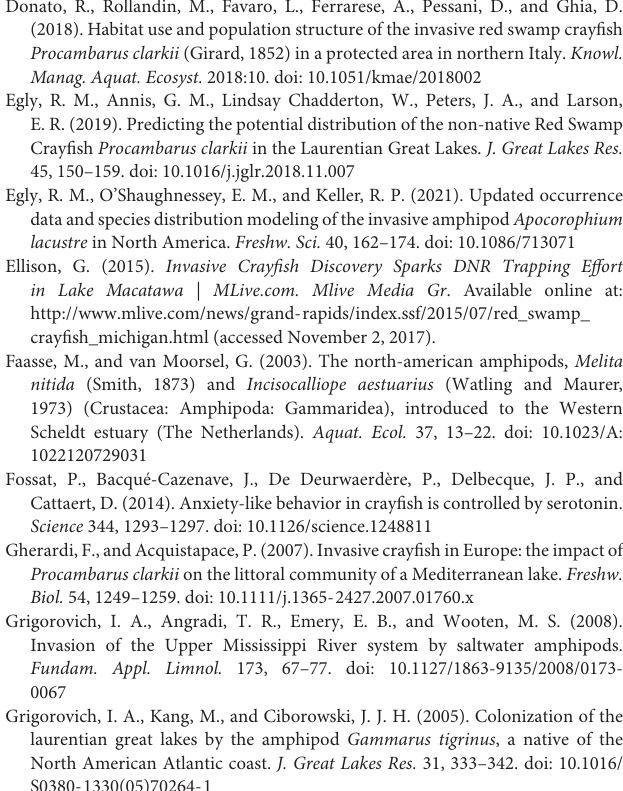
Supplementary Figure 2 | Behavior of Hyalella azteca during stimulus (barrier on) and post-stimulus (barrier off) phases for (A) 100%, (B) 200%, (C) 300%, and (D) 400% of existing barrier strengths. Supplementary Table 1 | Size of Procambarus clarkii individuals used in experiments for different electric field strengths. Supplementary Table 2 | Size of Hyallela azteca individuals used in experiments for different electric field strengths. Supplementary Material 3 | Electric barrier calibration report. Supplementary Material 4 | Order Parameter Data